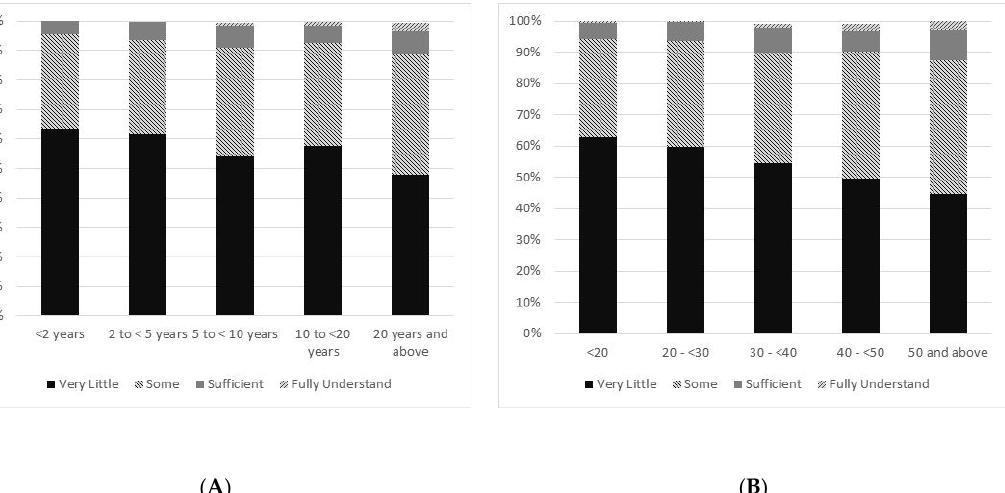
Figure 4. The effect of age ( A ) and residential time ( B ) on the awareness of Sponge City program.